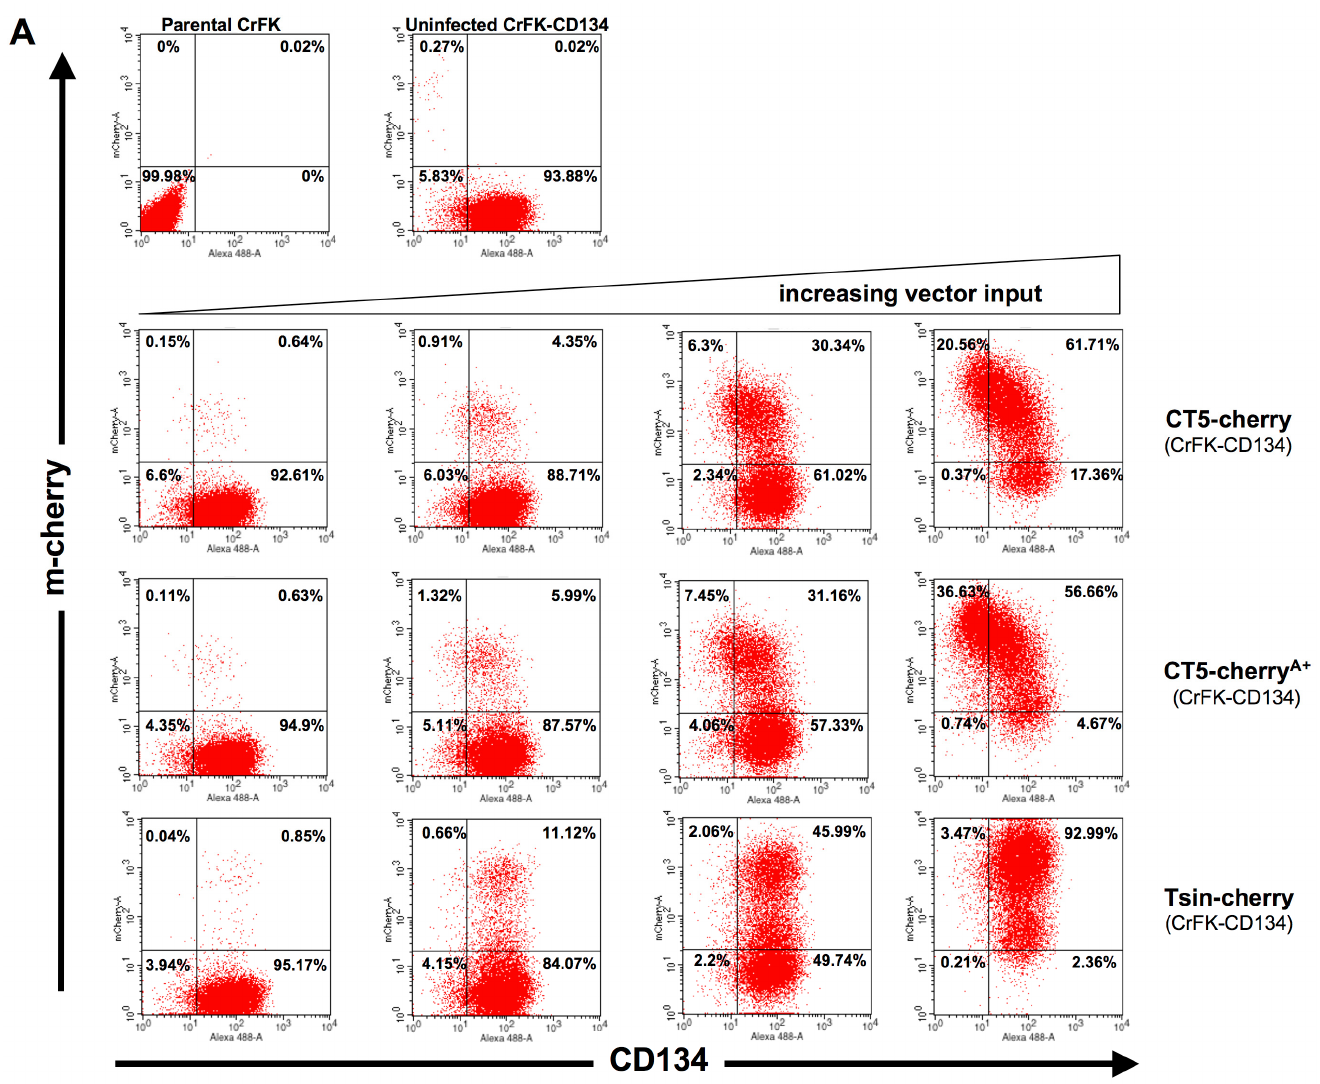
Figure 4. Testing of OrfA (+) and (-) reporter virus. (A) CrFK-CD134 cells were derived as described in the Experimental Section and the stable cell line was infected with increasing amounts of each CT5cherry or CT5-cherry A+ reporter virus. Lentiviral vector TsinCherry [25], which expresses mCherry under control of the hCMV promoter but encodes no viral proteins, was used as a control. Flow cytometry for CD134 surface expression was performed at 72 hours. (B) 30,000 CrFK-CD134 cells were infected with CT5efs and CTefs A+ viruses at equivalent MOI (0.5 and 2.6). MOI was calculated by pre-titration on CrFK-CD134 cells with the focal infectivity assay of Remington et al. [50]. Flow cytometry for CD134 surface expression was performed at 72 hours. Error bars represent standard deviations of duplicate measurements. (C) Immunoblotting for FIV Gag/Pol (top blot) and tubulin (bottom blot) in lysates of the cells shown in panel B (MOI = 2.6). Numbers indicate MW markers